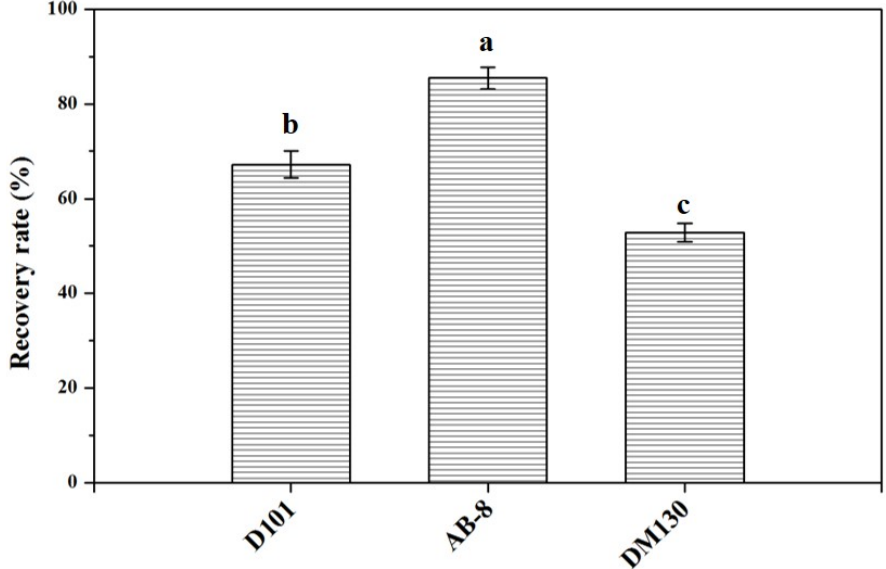
Figure 5. Recovery rates of flavonoid compounds from NADES systems with the three macroporous resins. Data sharing different letters were significantly different ( p < 0.05).